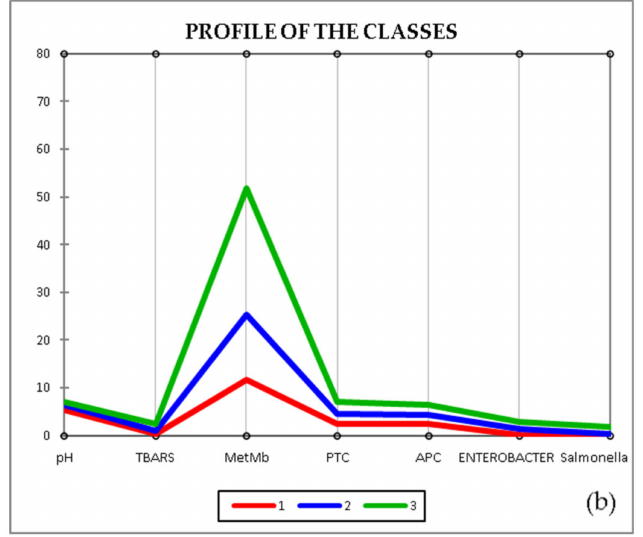
Figure 7. Agglomerative hierarchical cluster analysis (HCA) ( a ) and profile of classes ( b ) of physicochemical characteristics and microbial counts of different samples at each storage time: 0, 3, 7, and 14 days.